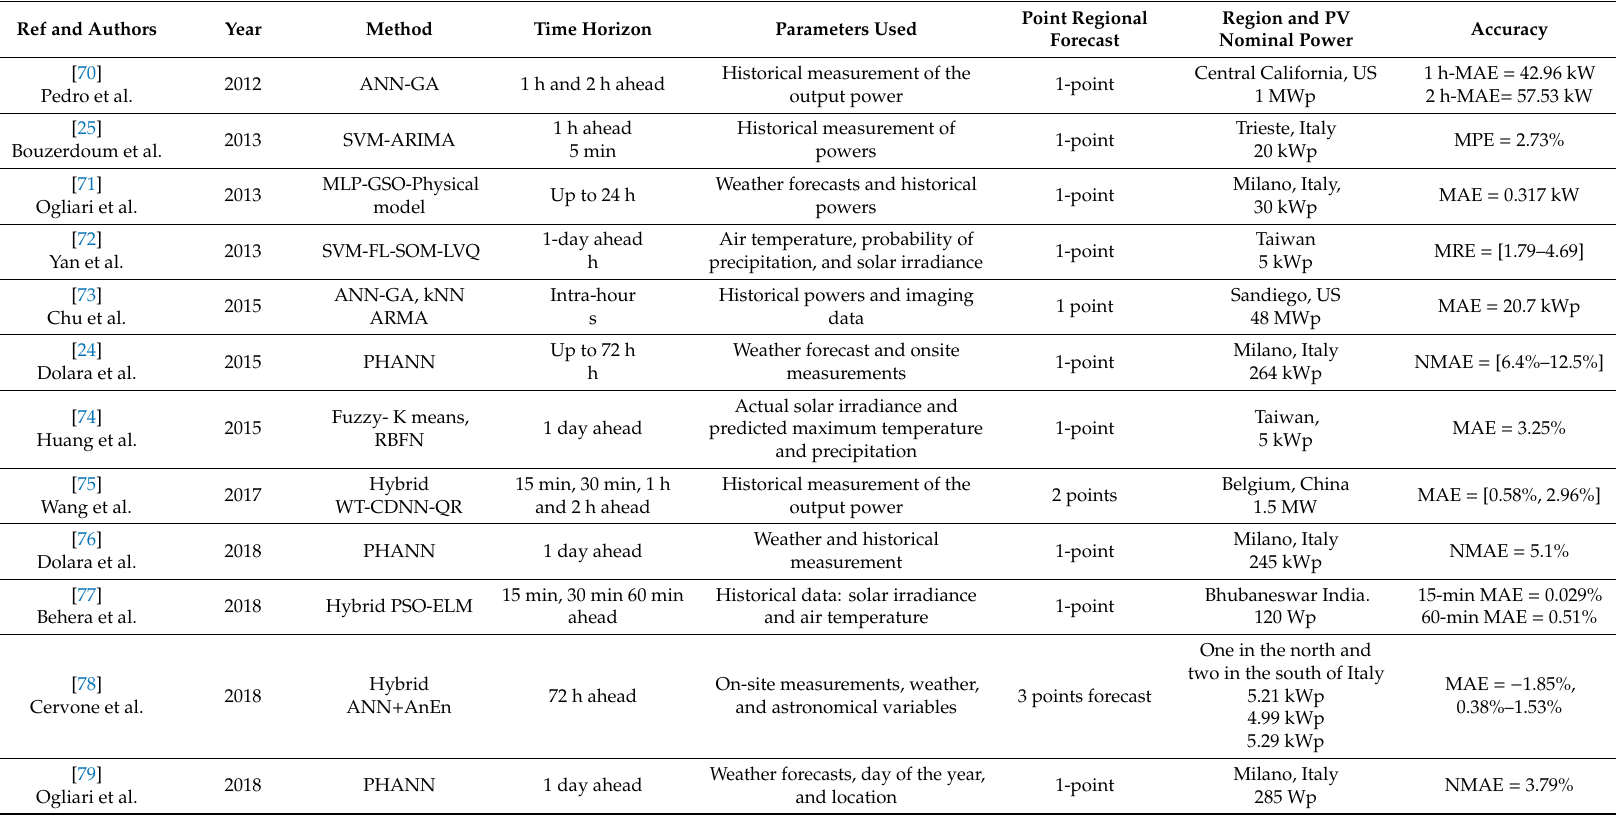
Table 4. Hybrid methods for the forecast of PV power-period